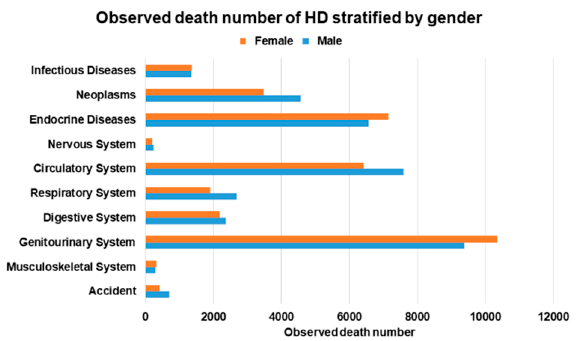
Figure 3. Observed death number of hemodialysis (HD) stratified by gender.